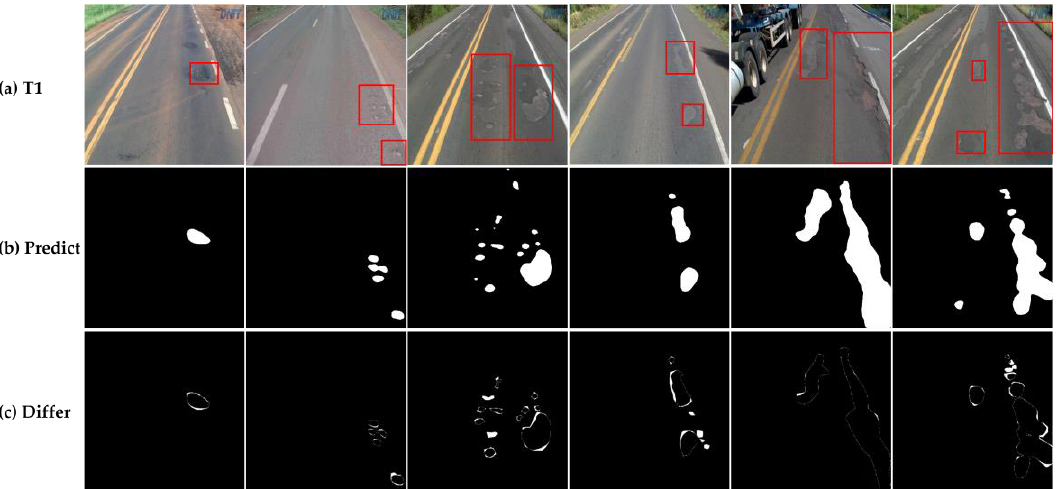
Figure 4. Visualization of segmentation test results on the CPRID. “Predict” represents the segmentation test results of our DMTC network and “Differ” represents the reduction between the predicted result and GT.